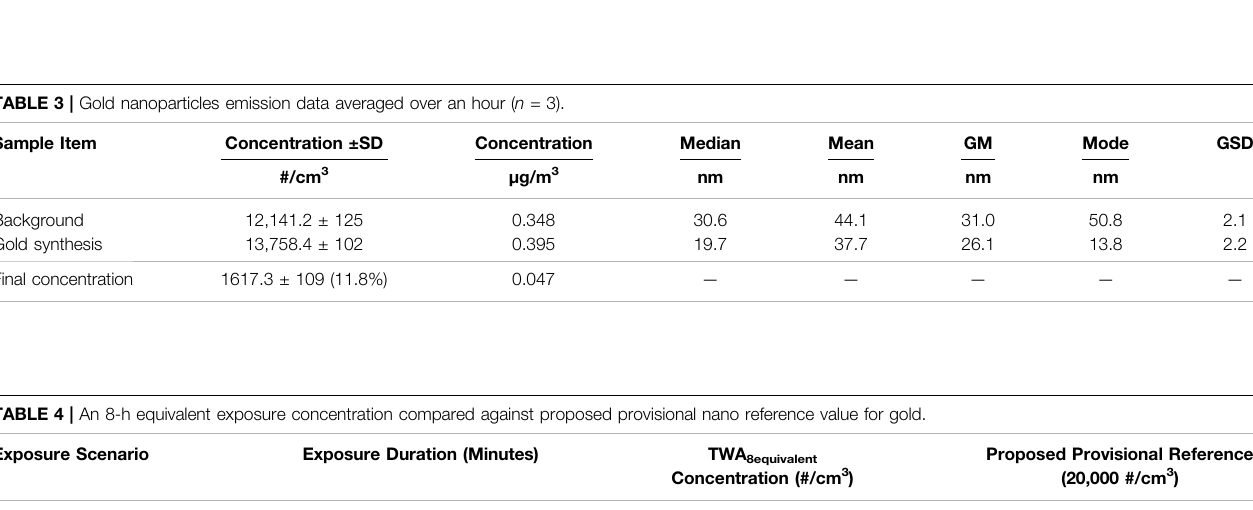
FIGURE 3 | (A) Particle number concentration for the background in the gold synthesis laboratory and (B) Particle number concentration for the gold synthesis process.